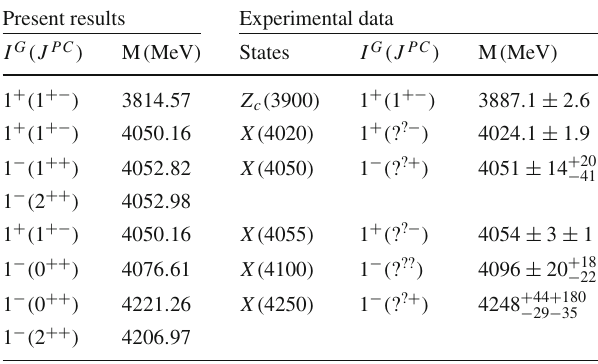
Table 11 The comparison of model results with experimental masses for Z